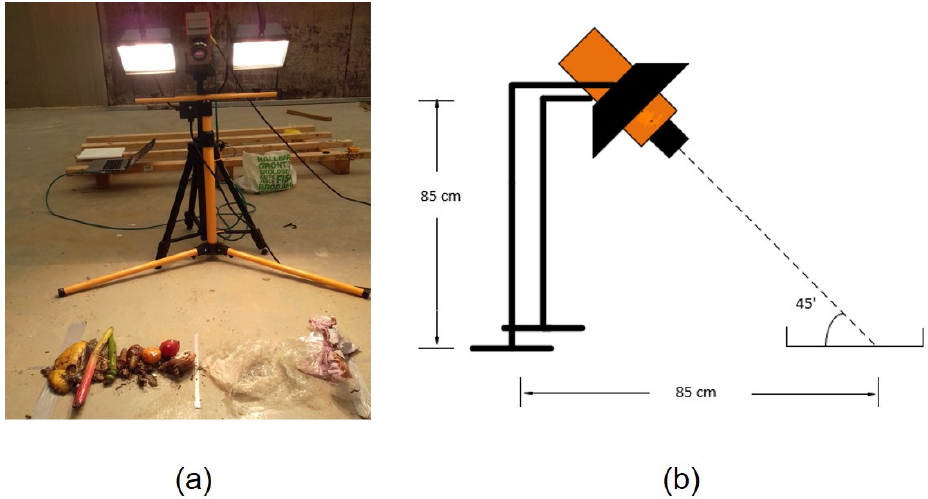
Figure 3. Experiment setup: ( a ) photo of the experiment setup, ( b ) schematic depiction of the experiment setup.